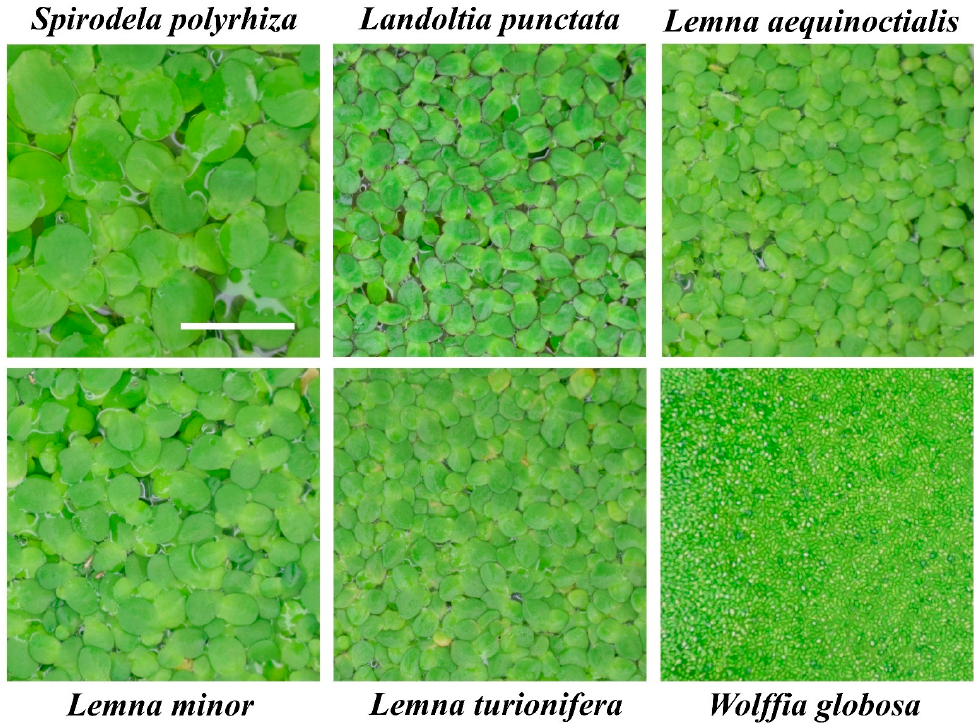
Figure 1. Images of the duckweed species used in the study at the exponential growth stage. All pictures were taken at the same magnification, bar corresponds to 1 cm. GenBank accession numbers for the atpF – atpH (ATP) and psbK – psbL (PSB) barcodes are: S. polyrhiza (NB5548), ATP MZ436185, PSB MZ436186; L. punctata (NB0031), ATP MZ436177, PSB MZ436178; L. aequinoctialis (NB0007), ATP MZ436181, PSB—MZ436182; L. minor (NB0020), ATP MZ436176; L. turionifera (NB0013), ATP MZ436179, PSB MZ436180; W. globosa (NB0015), ATP MZ436183, PSB